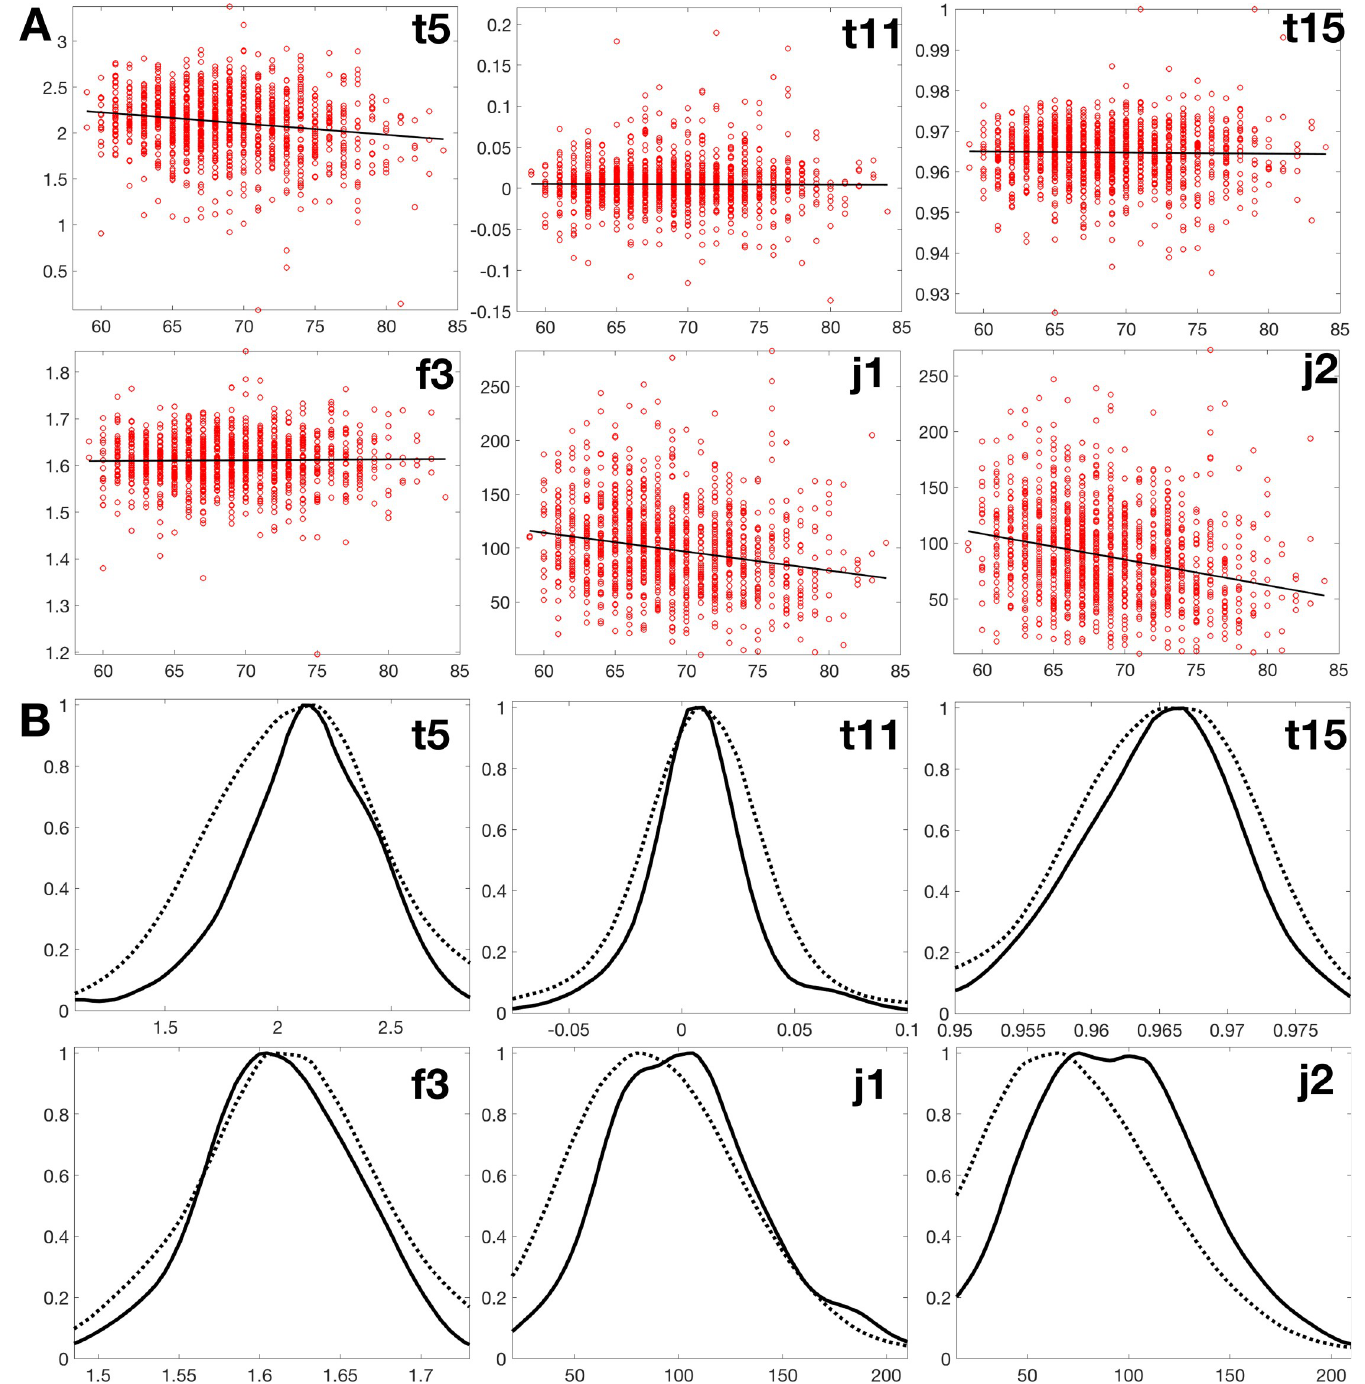
Fig 3. AREDS set. (A) Distribution of the same six microvascular traits as in Fig 2, ordinates and abscissas as in Fig 2. (B) Histograms (solid: < 68.8 y.o., dashed: > 68.8